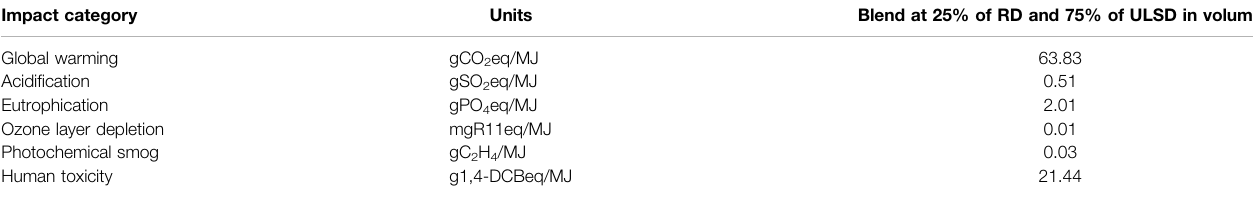
TABLE 4 | Effect of use of RD-ULSD blend on